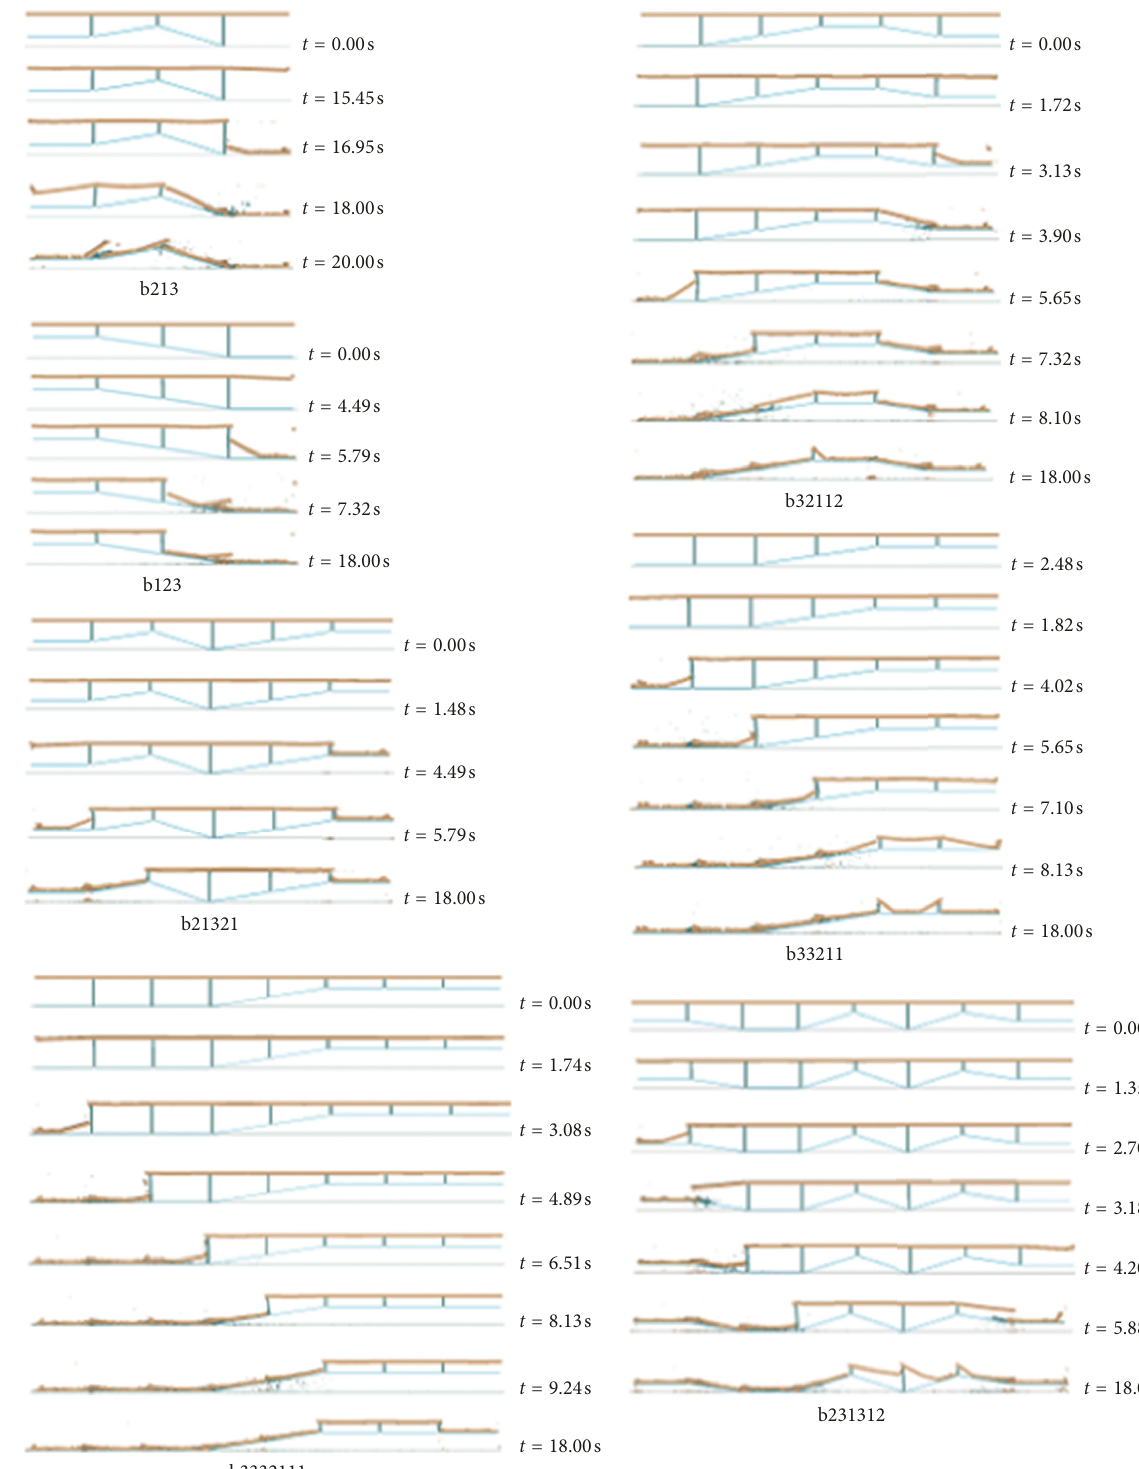
Figure 17: Collapse process of semiregular and irregular bridges under the artificial